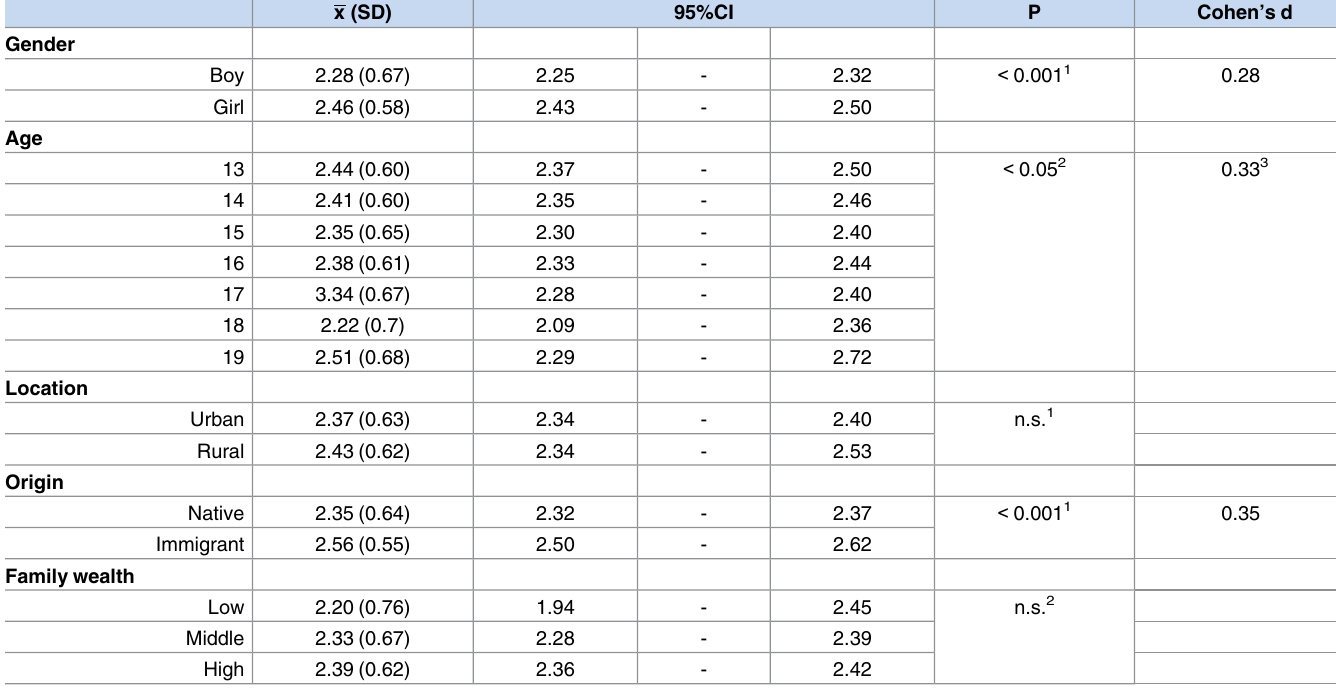
1 significance calculated with Student’s t-test; 2 significance calculated with the ANOVA test; 3 Magnitude of the effect between 13 and 19 years of age; n.s. = not significant